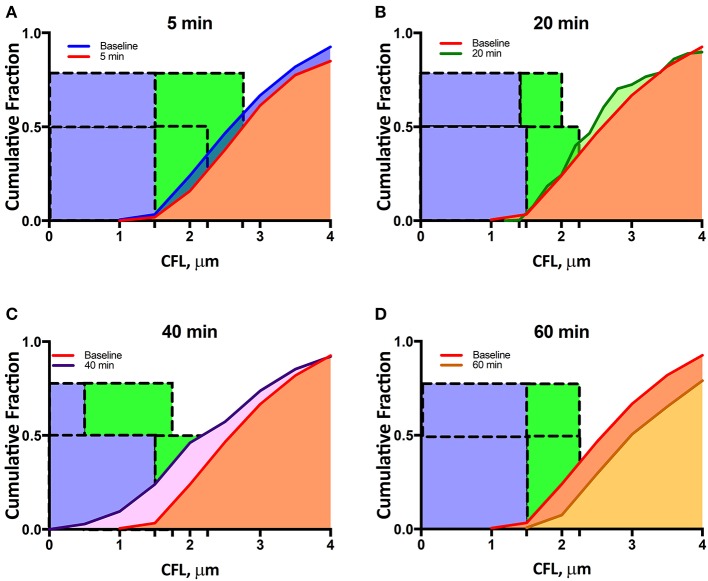
Single microvessel cumulative distribution function during enzymatic degradation of the EGL: CDFs at baseline and at (A) 5 min, (B) 20 min, (C) 40 min, and (D) 60 min after enzyme infusion. The blue bonding box represents the portion of the CFL influenced by the glycocalyx and its associated hydrodynamic forces, and the green bounding box represents the one-tailed 99% confidence interval of the CFL thickness (see Supplemental Figure 2).